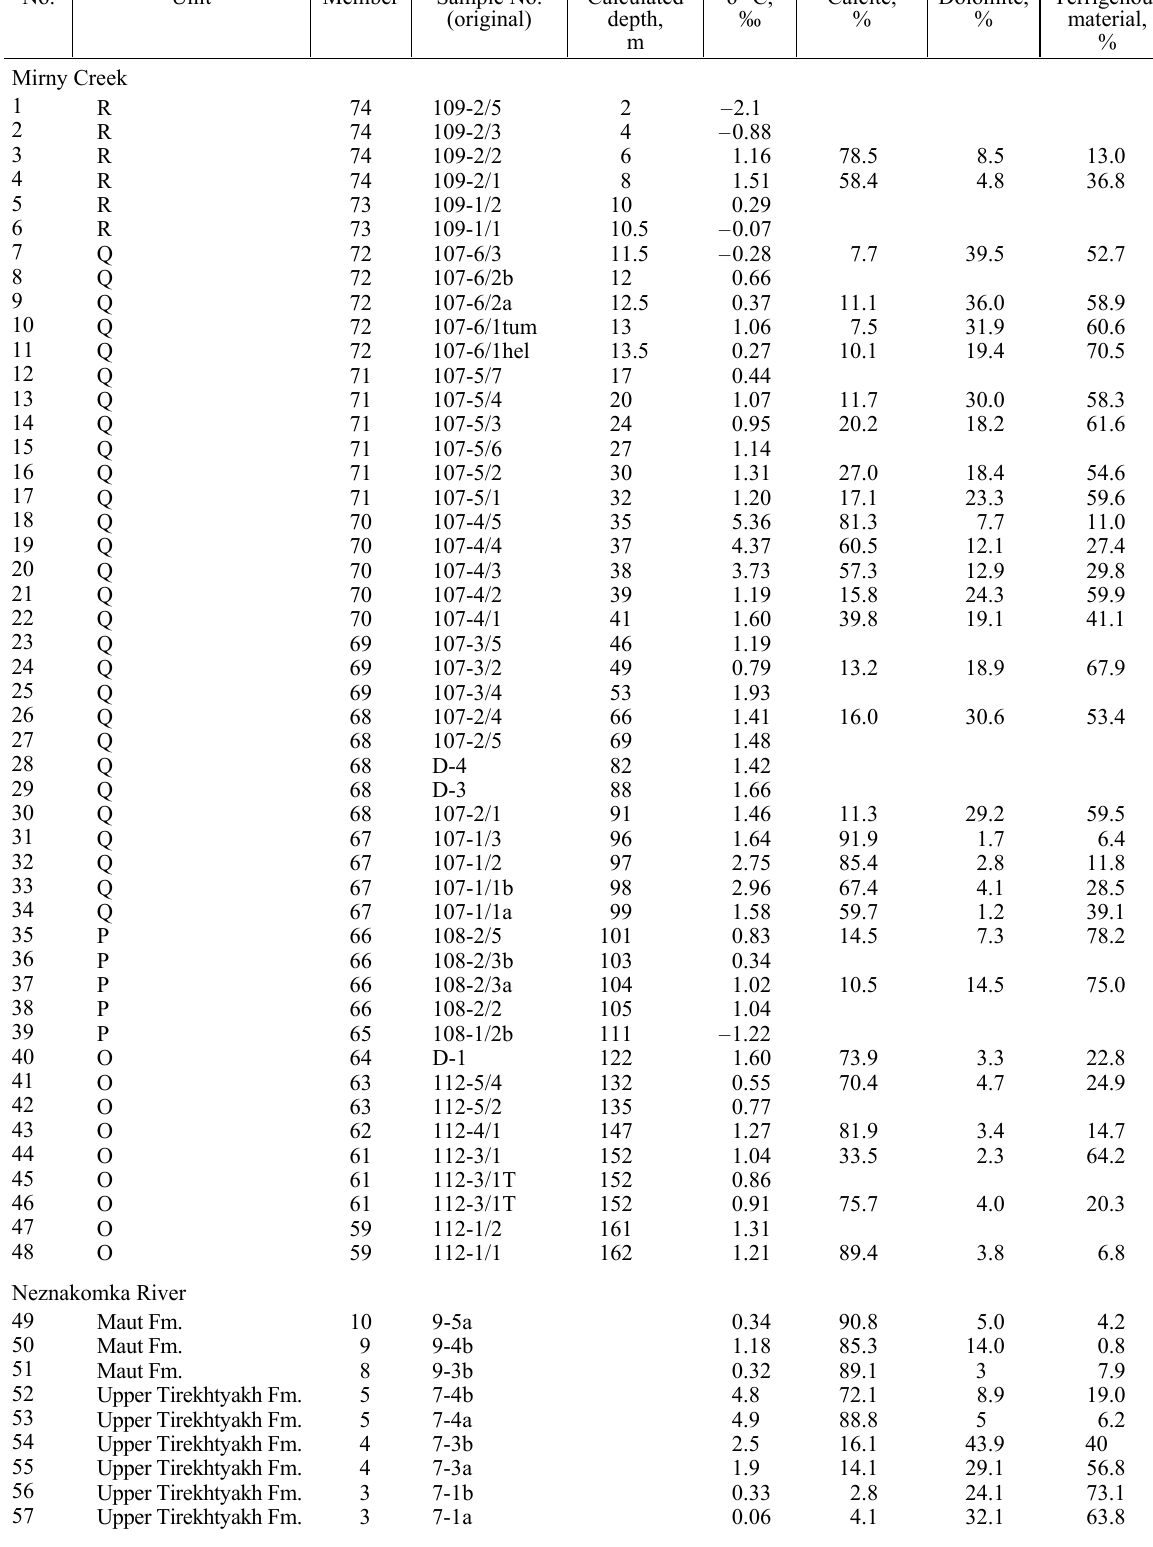
Table 1. Carbon isotope and geochemical data from the Mirny Creek and Neznakomka River sections. Calculated depth explained in the (cid:145)Material and methods(cid:146) section